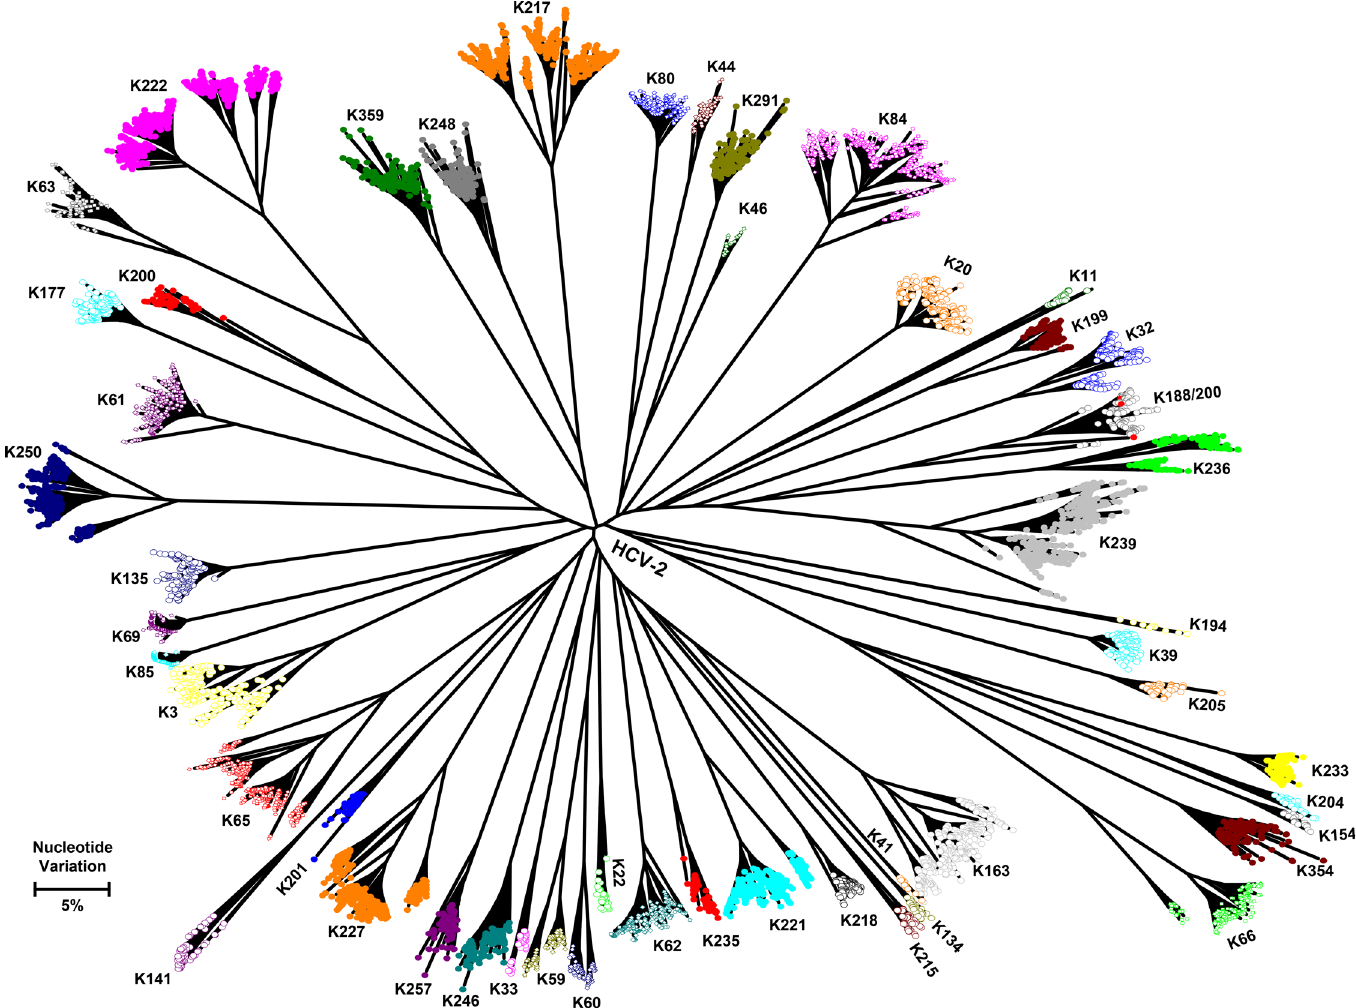
Fig 3. Maximum likelihood tree reconstructed with intra-host variants of HVR1 gene sequences of HCV genotype 2. Only unique haplotypes are shown. Individual samples are labeled with distinct identifiers beginning with letter ‘ k ’ and displayed with different